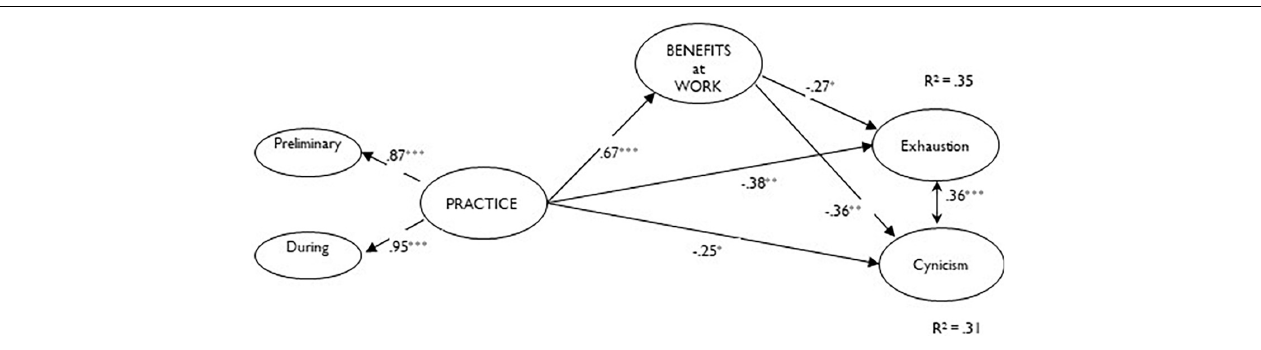
significance of my work. ” Items were rated on a 7-point frequency scale ranging from never (0) to daily